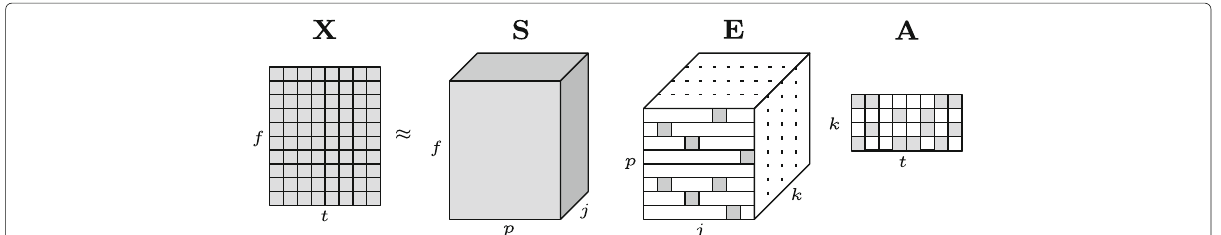
Fig. 3 Proposed signal model parameters. Zero values are displayed in white and non-zero values in